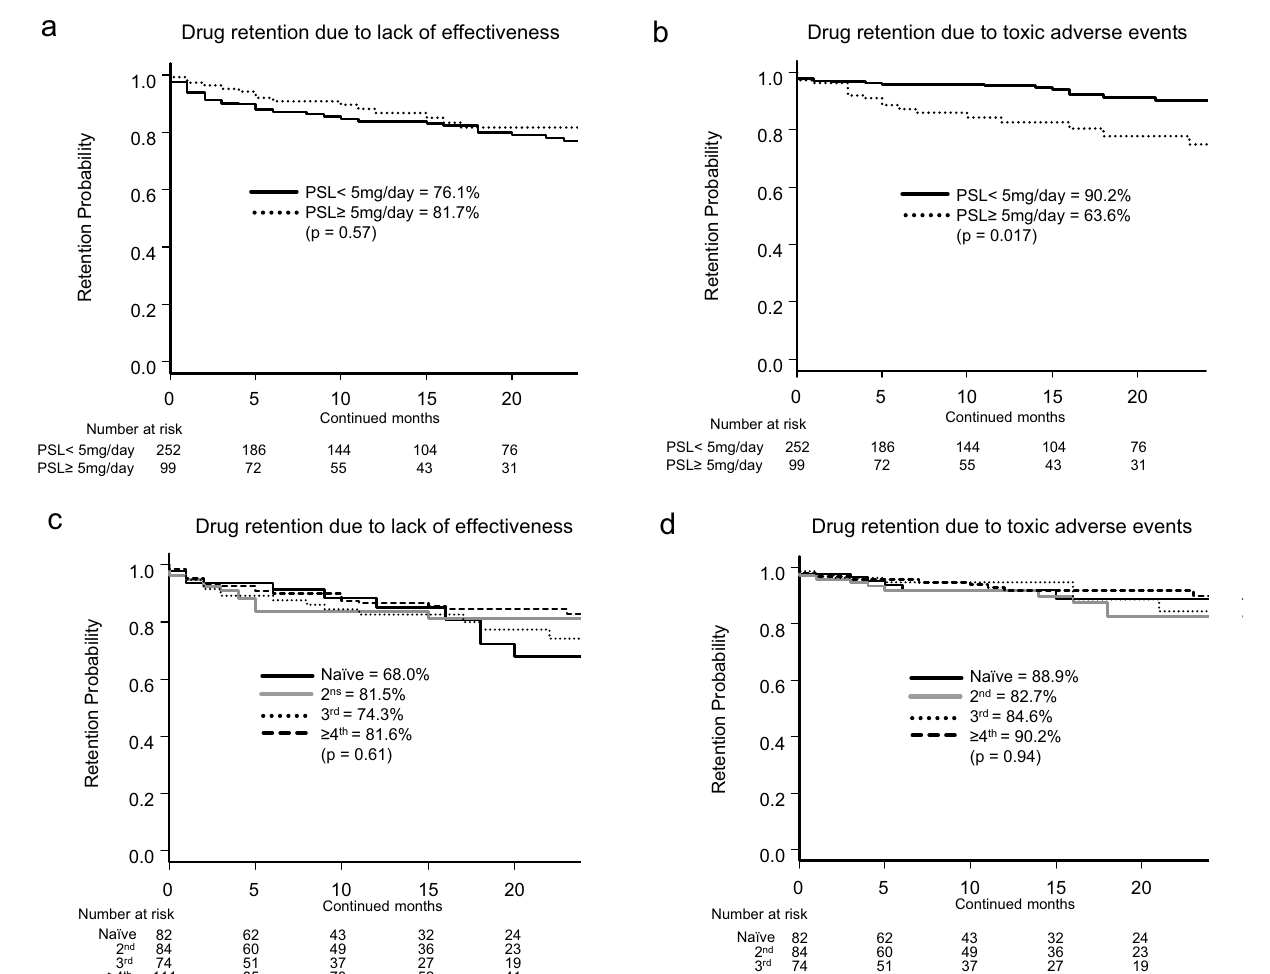
Figure 2. Adjusted drug retention by PSL dose and bDMARD/JAKi therapy. Adjusted drug retention between concomitant PSL < 5 mg/day and PSL ≥ 5 mg/day, due to ( a ) lack of effectiveness and ( b ) toxic adverse events, and adjusted drug retention between switched bDMARD/JAKi groups due to ( c ) lack of effectiveness and ( d ) toxic adverse events. PSL prednisolone, bDMARD biological disease-modifying antirheumatic drug, JAKi Janus kinase